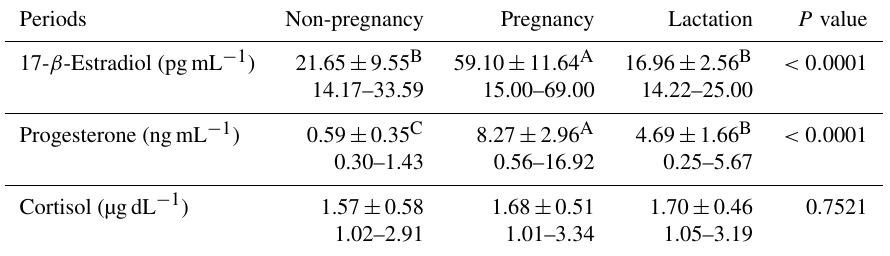
Table 1. Circulating 17- β -estradiol, progesterone, and cortisol concentrations (mean ± SD) and minimum and maximum values in different physiological periods of 30 Nicastrese goats. Within each row, different superscript letters indicate significantly different values.